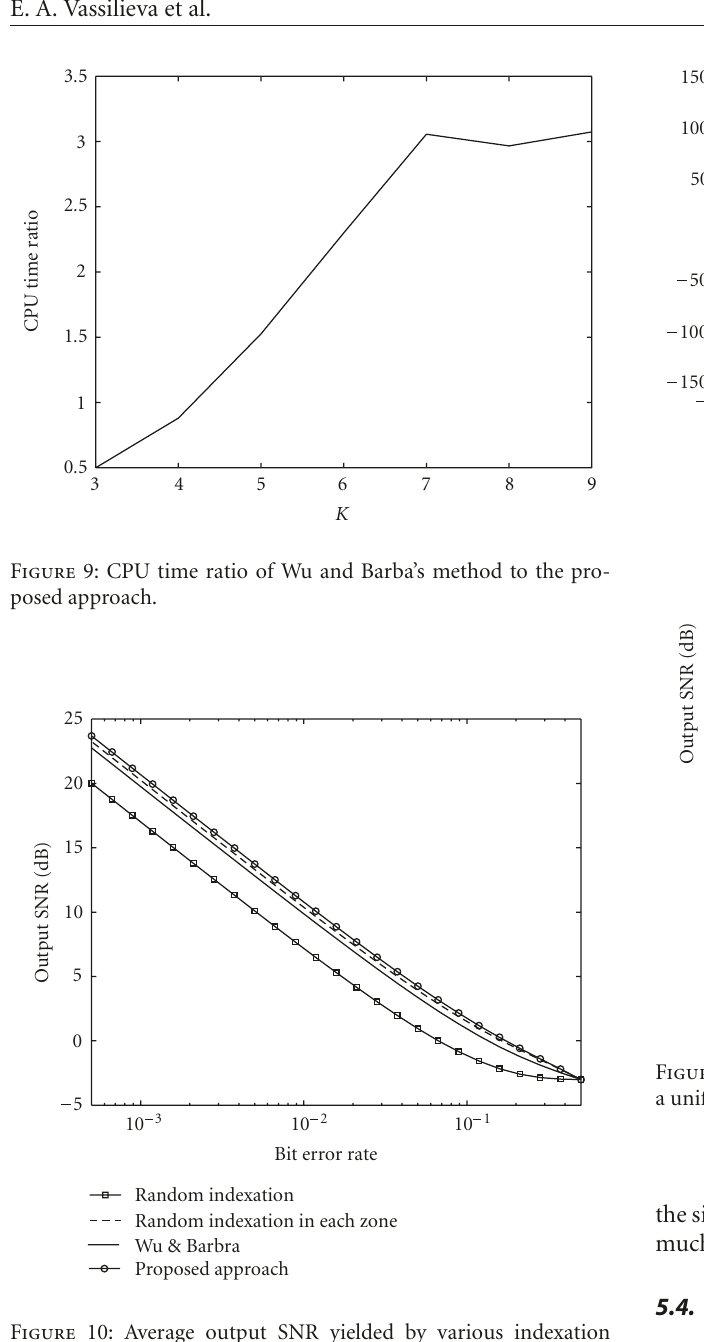
Figure 10: Average output SNR yielded by various indexation schemes on 1024-vector 25-dimensional codebooks.